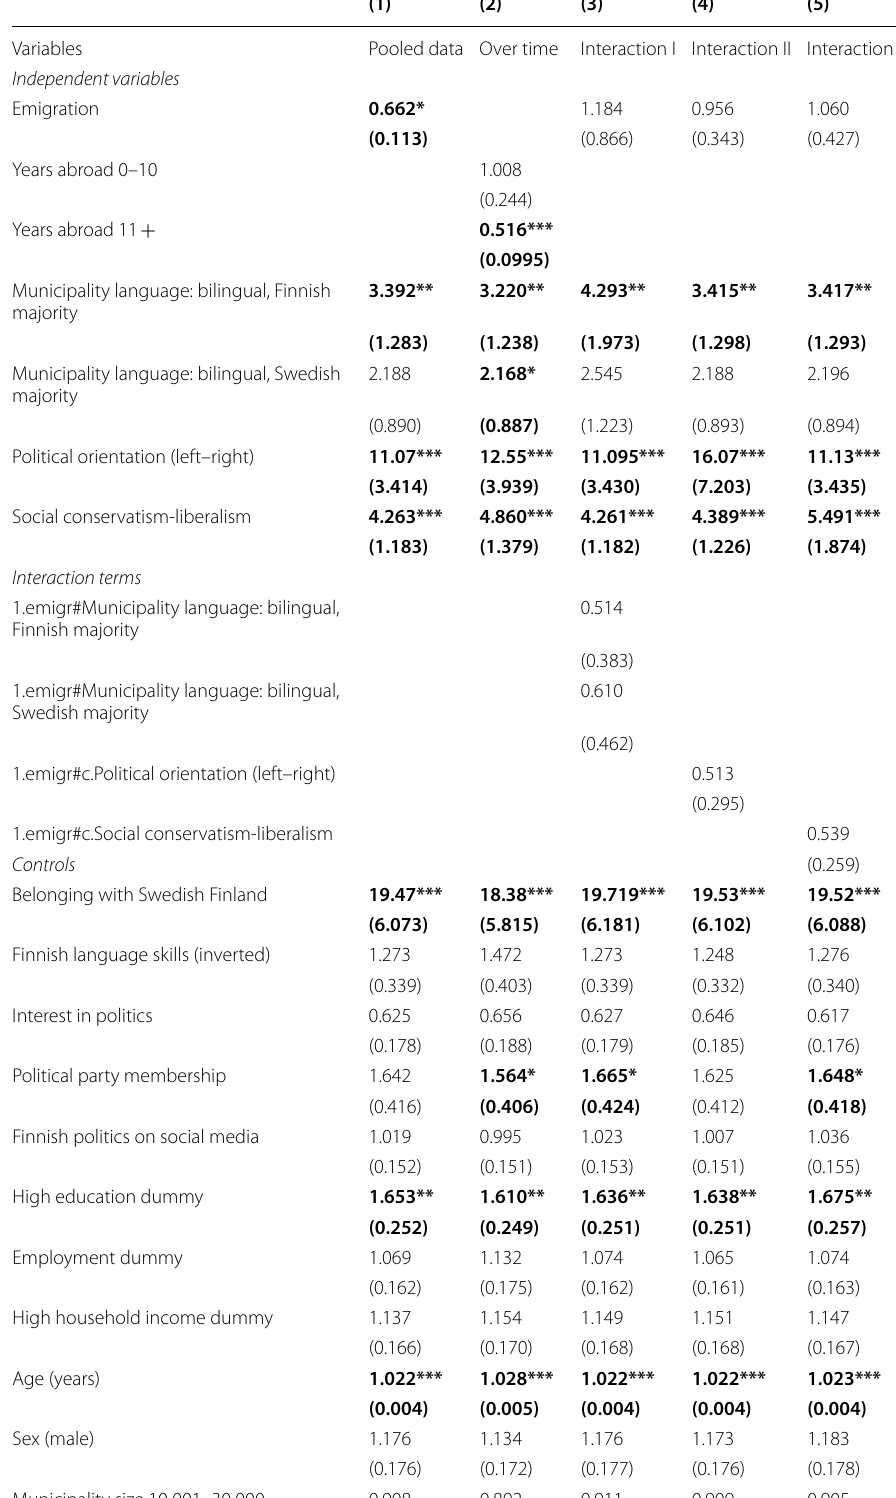
Table 1 Logistic regression of language-ethnic identity’s effect on party tie between emigrant and non-emigrant Finnish-Swedes